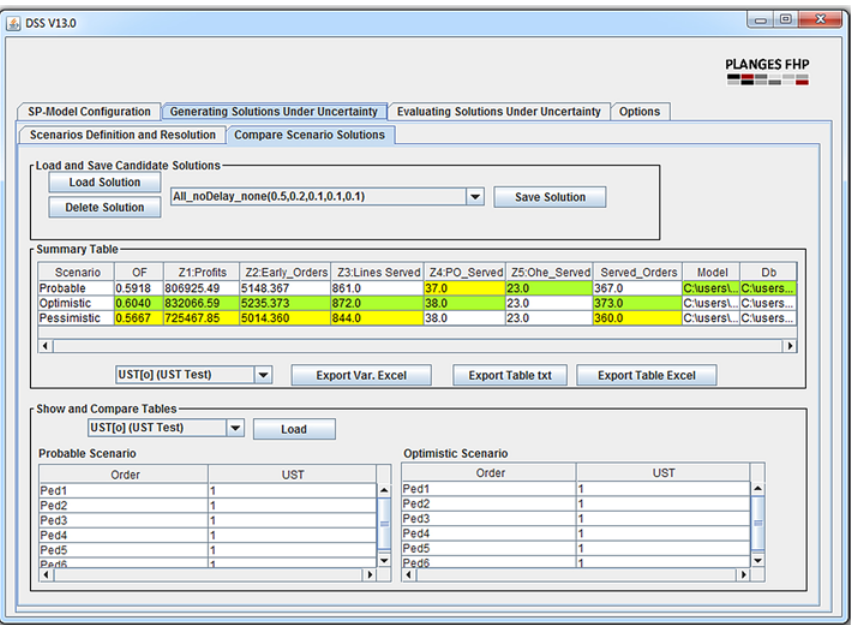
Fig. 6. The “Compare Scenario Solutions” DSS